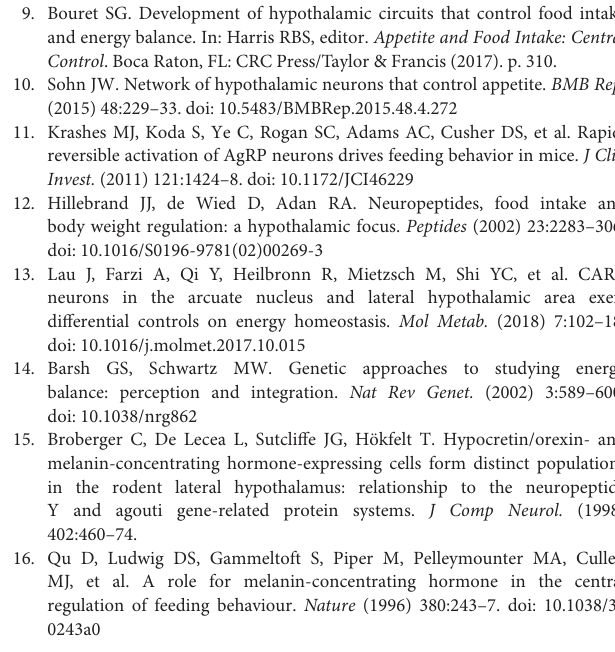
directly intervene in the innervation of Hcrt cell bodies in the